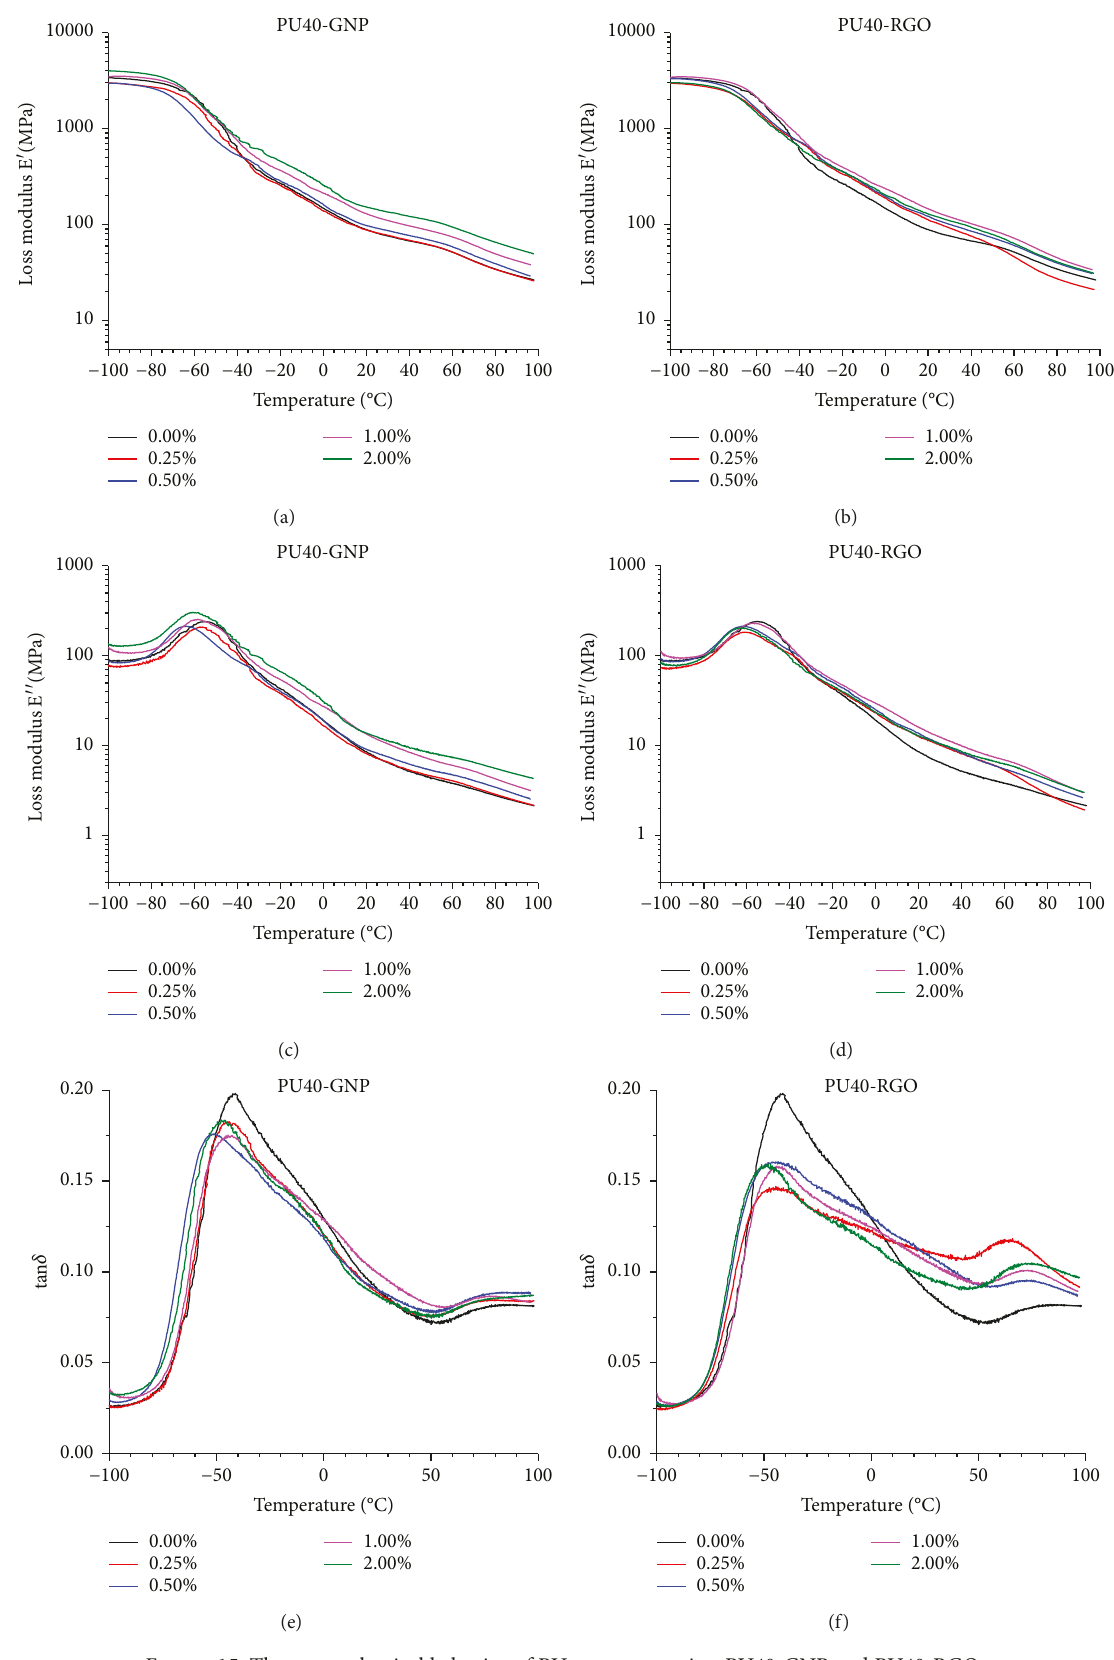
Figure 15: Thermomechanical behavior of PU nanocomposites PU40-GNP and